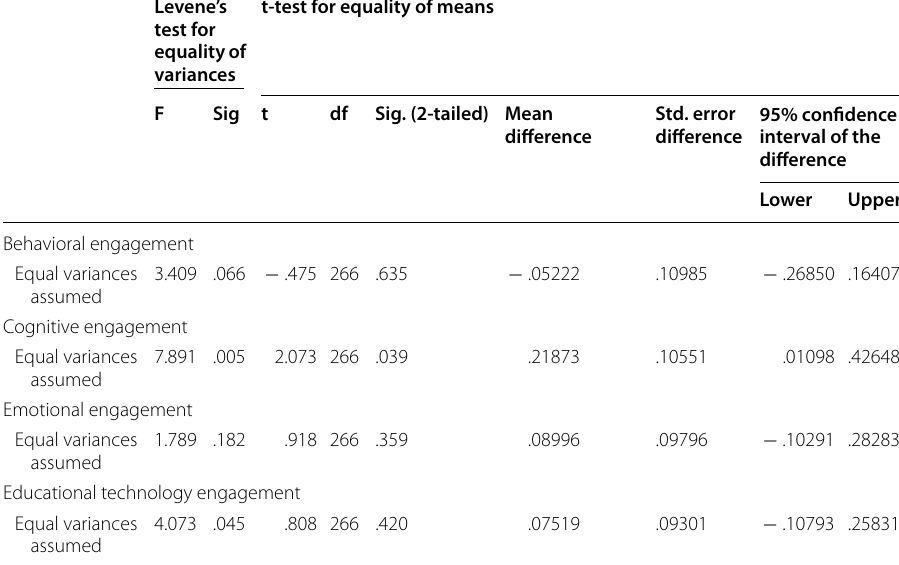
Table 8 Independent samples test of different